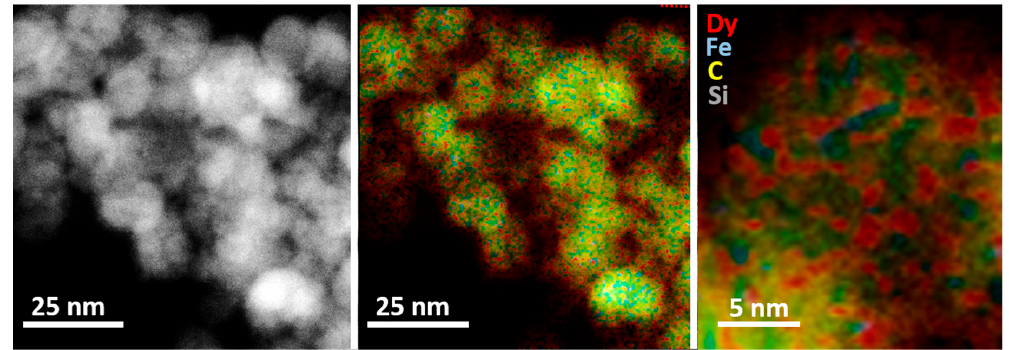
Figure 13. ( Left ) HAADF image of a cluster of NP@DTPA-Dy nanoparticles; ( Middle ) Elemental map image obtained by EDS analyses of the same NP@DTPA-Dy nanoparticles cluster. ( Right ) Enlarged image of the selected area from the middle image. The red, blue, yellow and green colors correspond to the presence of Dy, Fe, C and Si in the nanoparticles, respectively (adapted with permission from [35]).